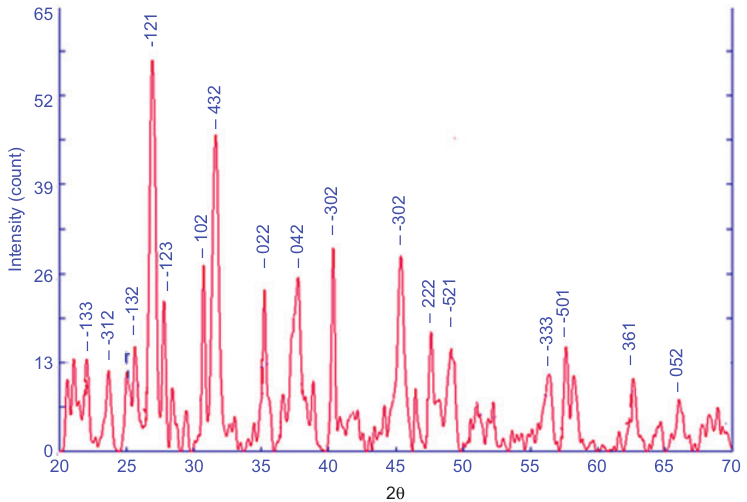
Figure 1 X-Ray diffraction screening of the complex [Ph